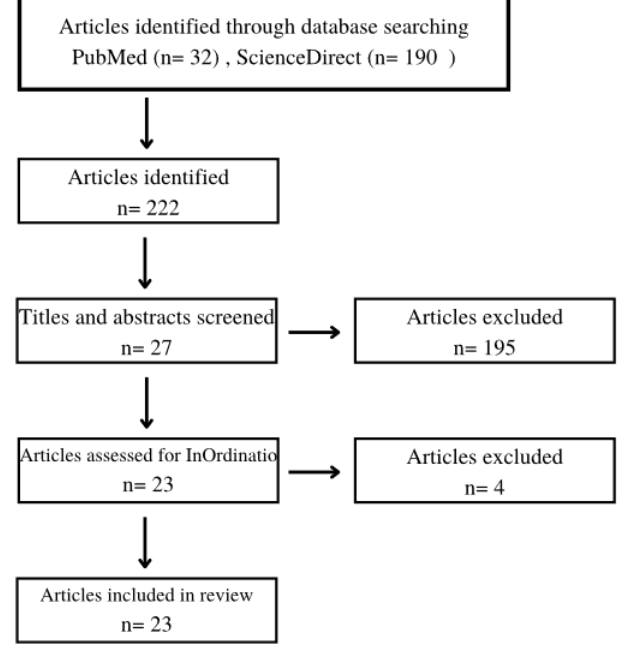
Figure 1. Flowchart of the study selection process.